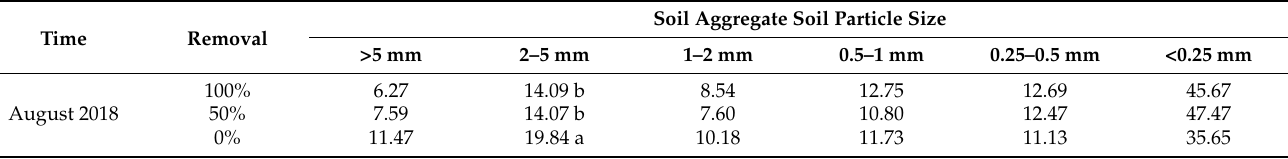
Table 4. Mass percentages of aggregates in different sizes during August 2018 to April